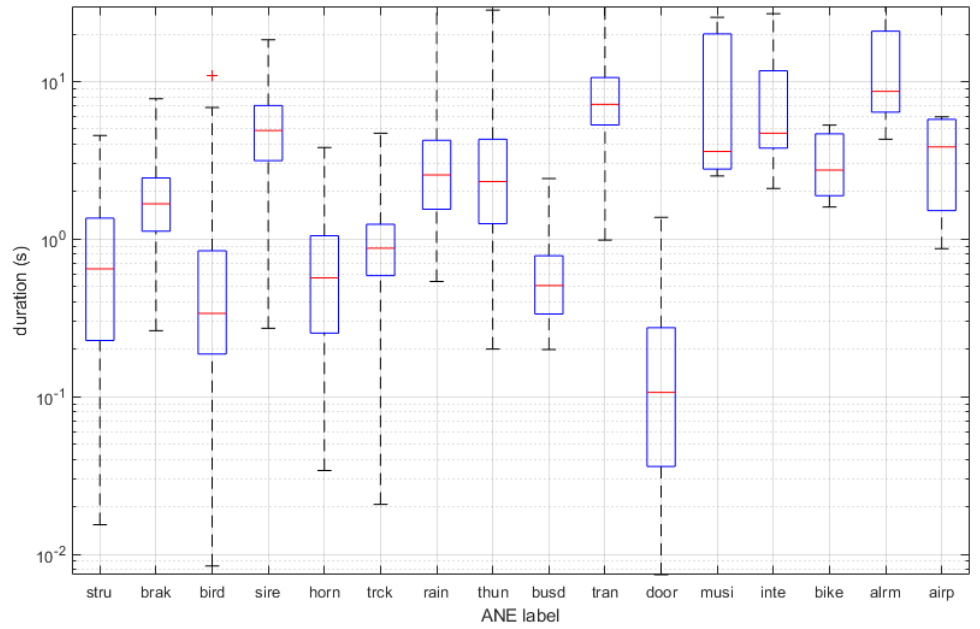
Figure 6. Boxplots of duration for each ANE category. Logarithmic axis of duration is used for a better observation of the duration